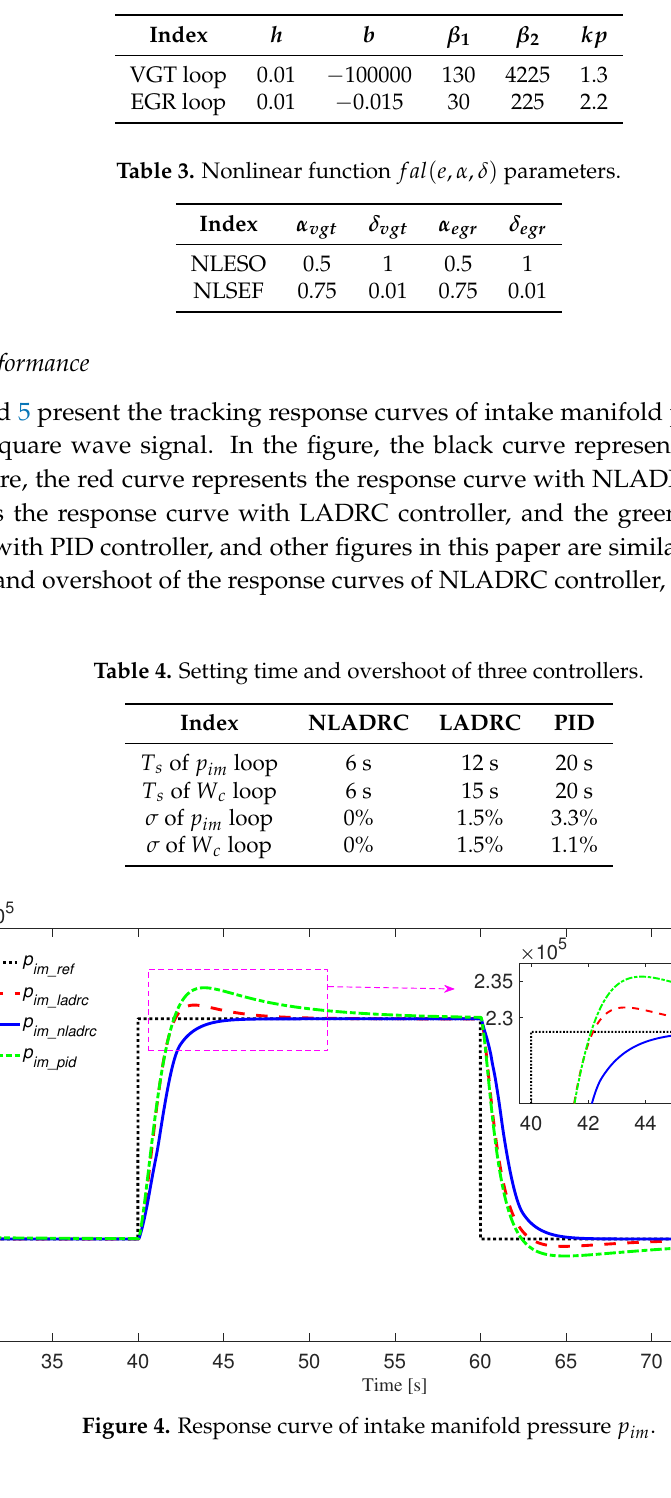
Table 2. LADRC controller parameters.